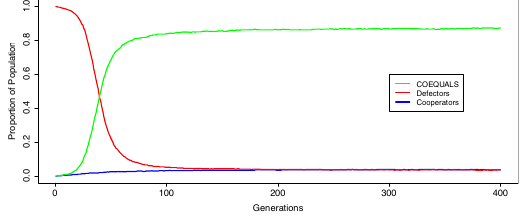
Figure 2. Growth and decline of strategies. From our 5,000 simulation runs, we gathered the distribution of each strategy’s proportion of the population in every generation; then, in Fig. 2, we traced the medians of these distributions from the first ( g = 1) to the last generation ( g = 400). The green line represents the median of COEQUALS’ distribution of population shares at each generation, while the red line conveys the corresponding information for the defector strategy and the blue line signifies that information for the cooperator strategy. The steep increase of the green line indicates the rapid spread of COEQUALS. The 23 rd generation is the median generation—across runs—by which COEQUALS spreads to over 50% of the population’s agents. From the 250 th to 400 th generation, the median percent of the population adopting COEQUALS approximately equals 87%, whereas defectors constitute a median percent less than 4% of the population during those generations. Furthermore, after the 250 th generation, the first-quartile of the distribution of COEQUALS’ percent of the population rests at approximately 59% and by the final generation the first-quartile of the distribution of COEQUALS’ population share increases to 64%, thus suggesting considerable selection for COEQUALS even in simulation runs in which the strategy grew less successfully.